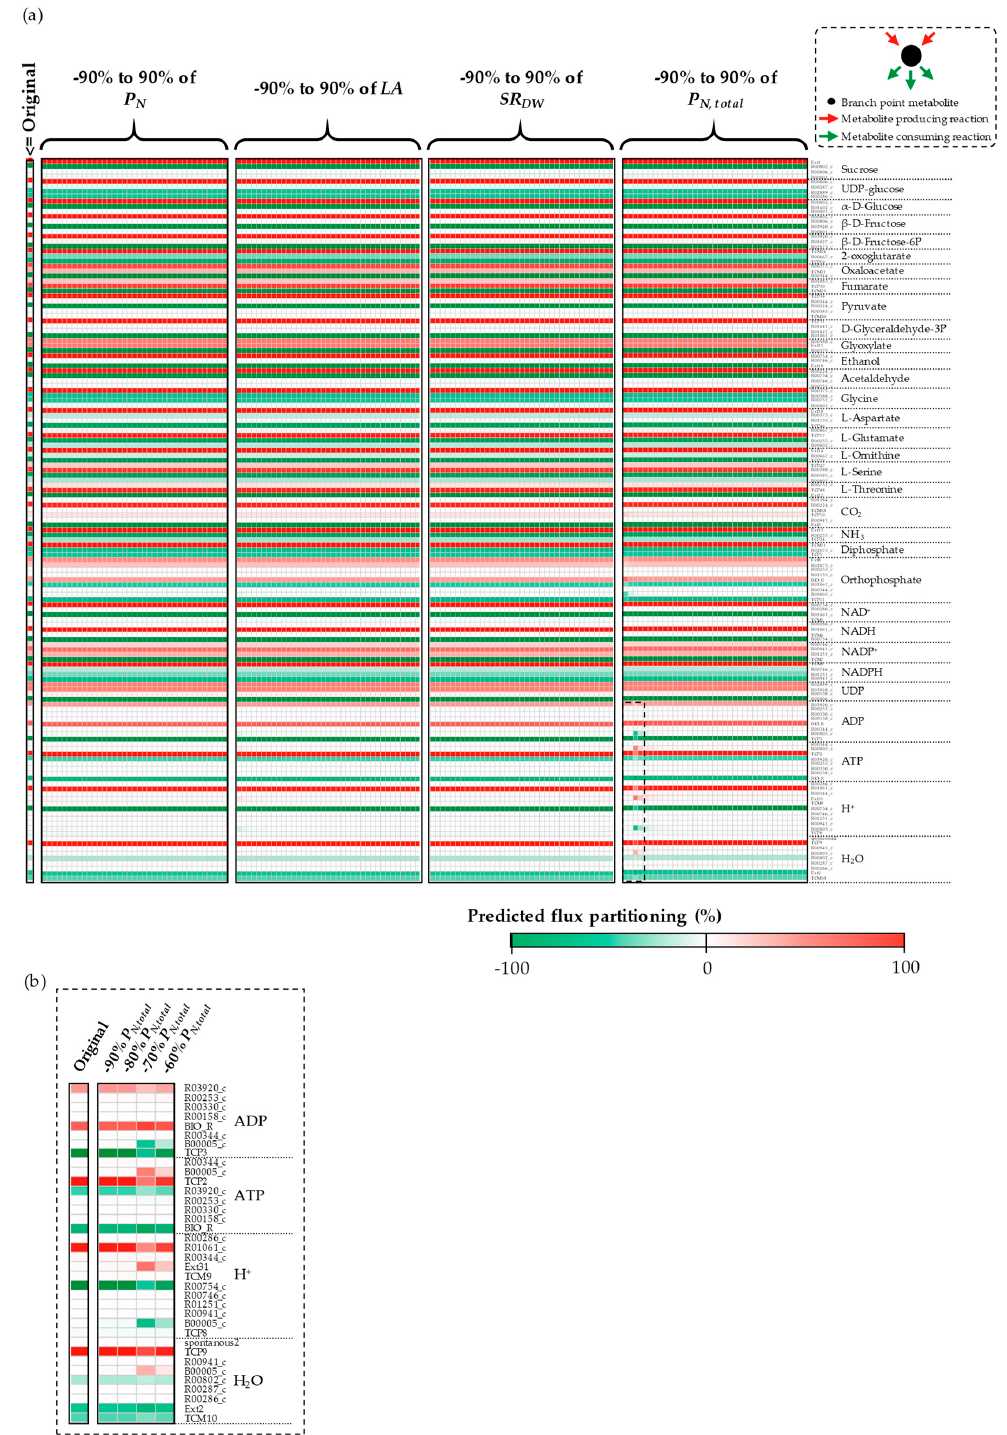
Figure A6. ( a ) The sensitivity of the cytosolic reaction flux partitioning to variations in the sucrose uptake rate-related data. ( b ) The influence of − 90% to − 60% variations of total photosynthetic rate on flux partitioning by the rMeCBM-KU50 model. Details of the metabolic branch points along with the corresponding reactions are provided in the Supplementary Materials (File S2). A difference in grid color between the original (first column) and predicted fluxes is indicative of dissimilarity in partitioning (breakpoint). The production and consumption fluxes at each metabolic branch point were respectively denoted as positive and negative signs. LA ; total leaf area per plant; P N , photosynthetic rate; P N, total , total photosynthetic rate per plant; SR DW , storage root dry weight per